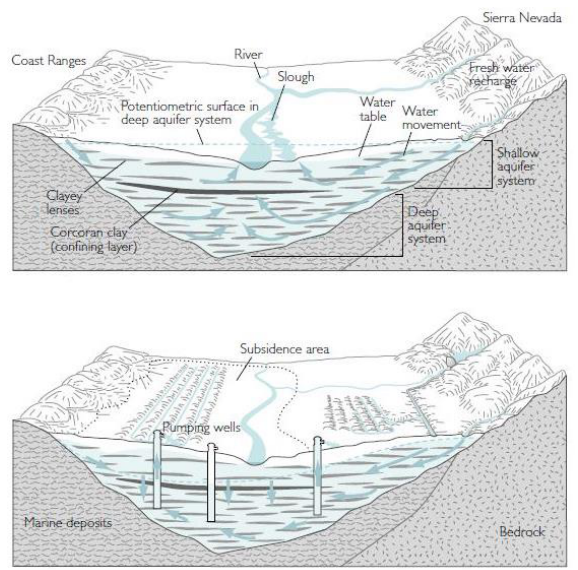
Figure 2. Cross-section of San Joaquin Valley during predevelopment ( top ) and post-development ( bottom ) period. Figure from reference